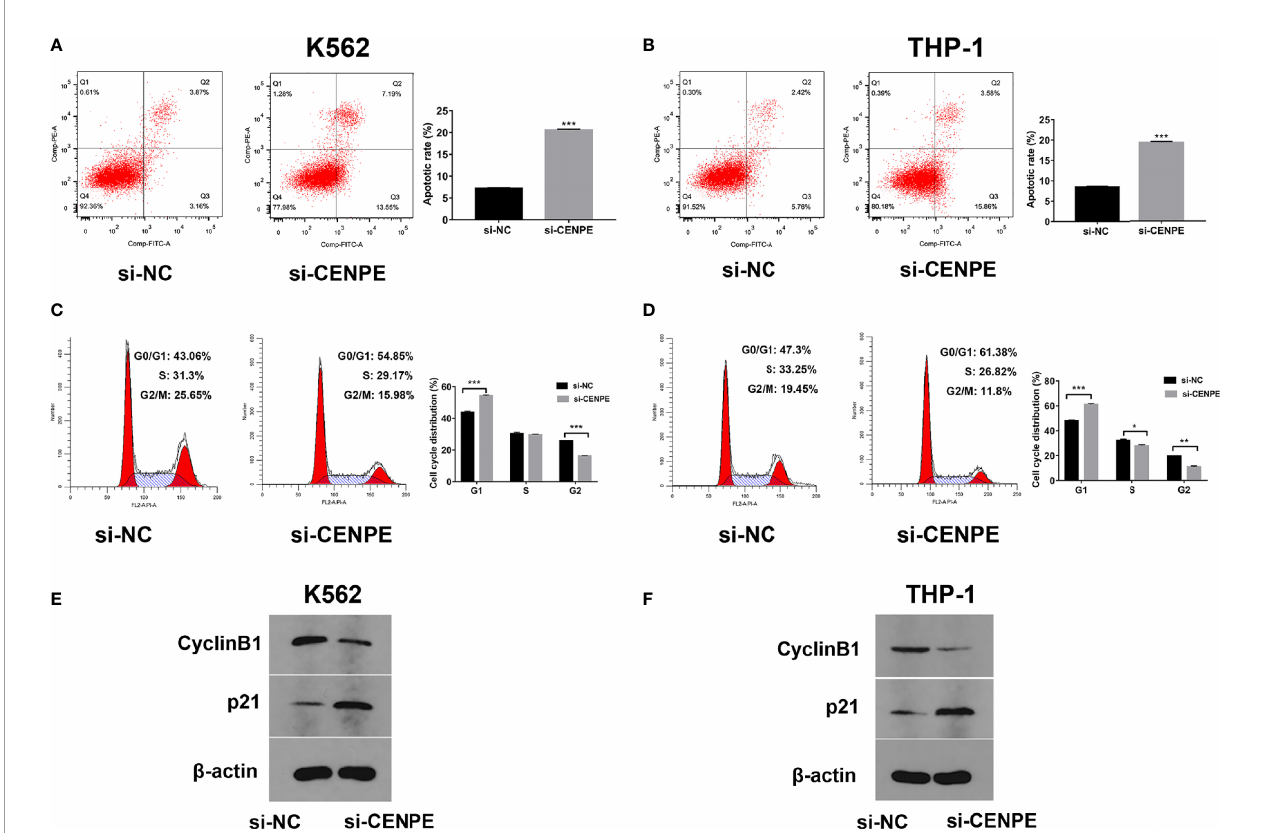
FIGURE 3 | CENPE interference effected K562 and THP-1 cell apoptosis and cell cycle and drug resistance. (A, B) After 48 h of transfection, cell apoptosis was measured by fl ow cytometry. The cell apoptotic rates between si-NC and si-CENPE groups were analyzed in K562 and THP-1 cells. (C, D) After 48 h of transfection, cell cycle was measured by PI single-staining method. (E, F) After 48 h, Western blot analyzed the expression of cycle-related proteins Cyclin B1 and p21 in K562 and THP-1 cells. * p < 0.05. ** p < 0.01. *** p <